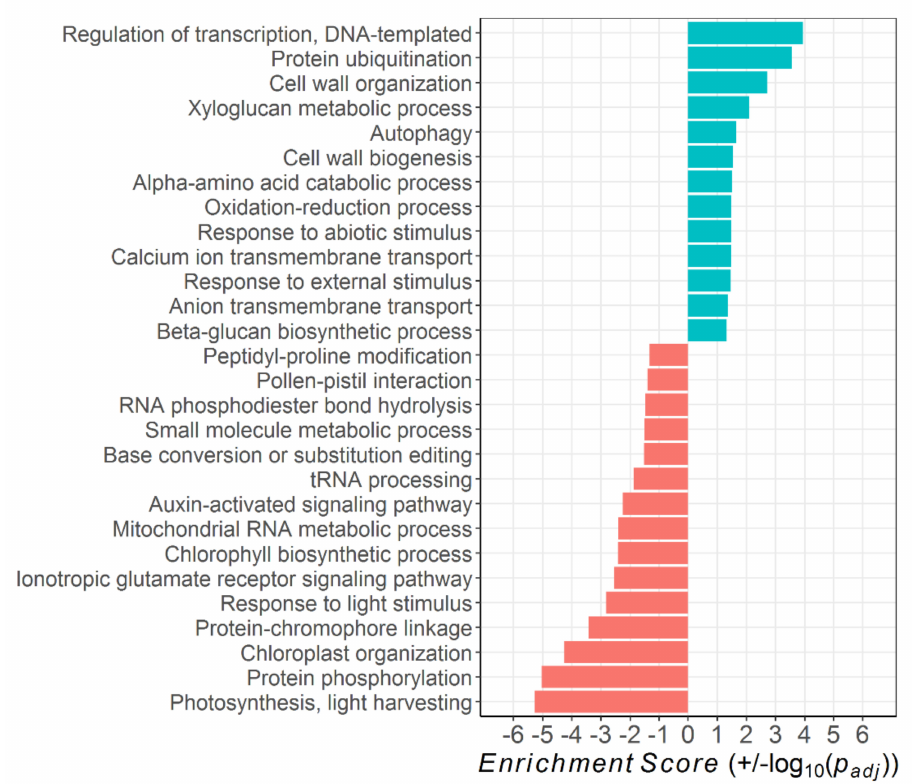
Figure 4. Significantly up- and downregulated ( p adj < 0.05) Gene Ontology biological processes in leaves of ethephon-treated vs. control Vitis vinifera cv. Riesling vines. The Enrichment Score gives the log 10 of the p adj -value according to Fisher’s Exact Test